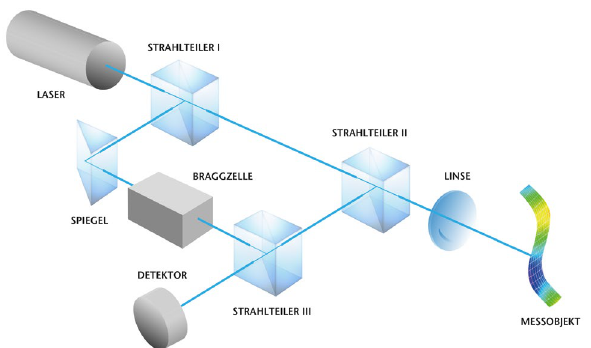
Fig. 2. Basic principle and schematic structure of a Laser Doppler interferometer from Polytec GmbH [3]